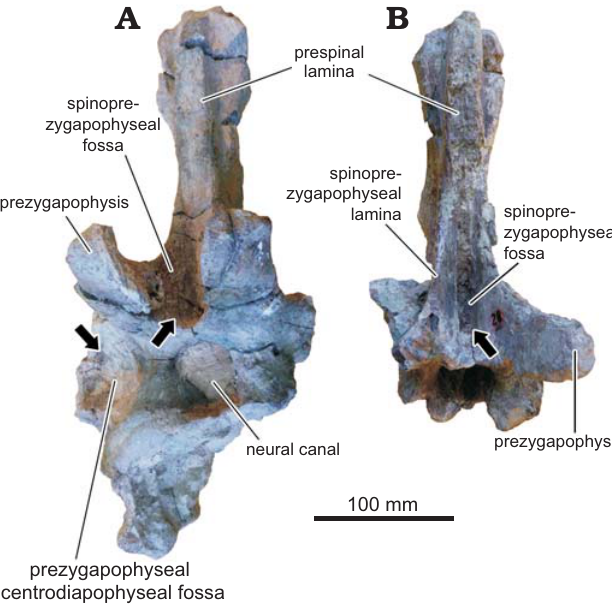
Fig. 8. Anterior view of anterior caudal vertebrae of rebbachisaurid sauropod Katepensaurus goicoecheai Ibiricu, Casal, Martínez, Lamanna, Luna, and Salgado, 2013a from the Cenomanian–Turonian Bajo Barreal Formation of Chubut Province, Argentina. A . UNPSJB-PV 1007/7. B . UNPSJB-PV 1007/8. Hypothesized pneumatic fossae indicated by